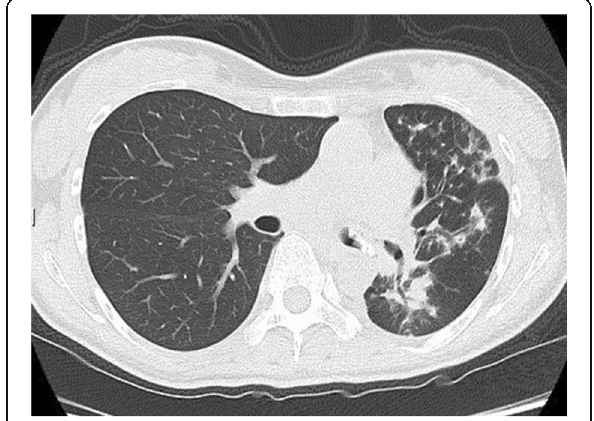
Fig. 1 Axial chest computed tomography (CT) images at admission show a mass surrounding the patient ’ s left lower bronchus stump with endobronchial extension causing significant obstruction of the left upper